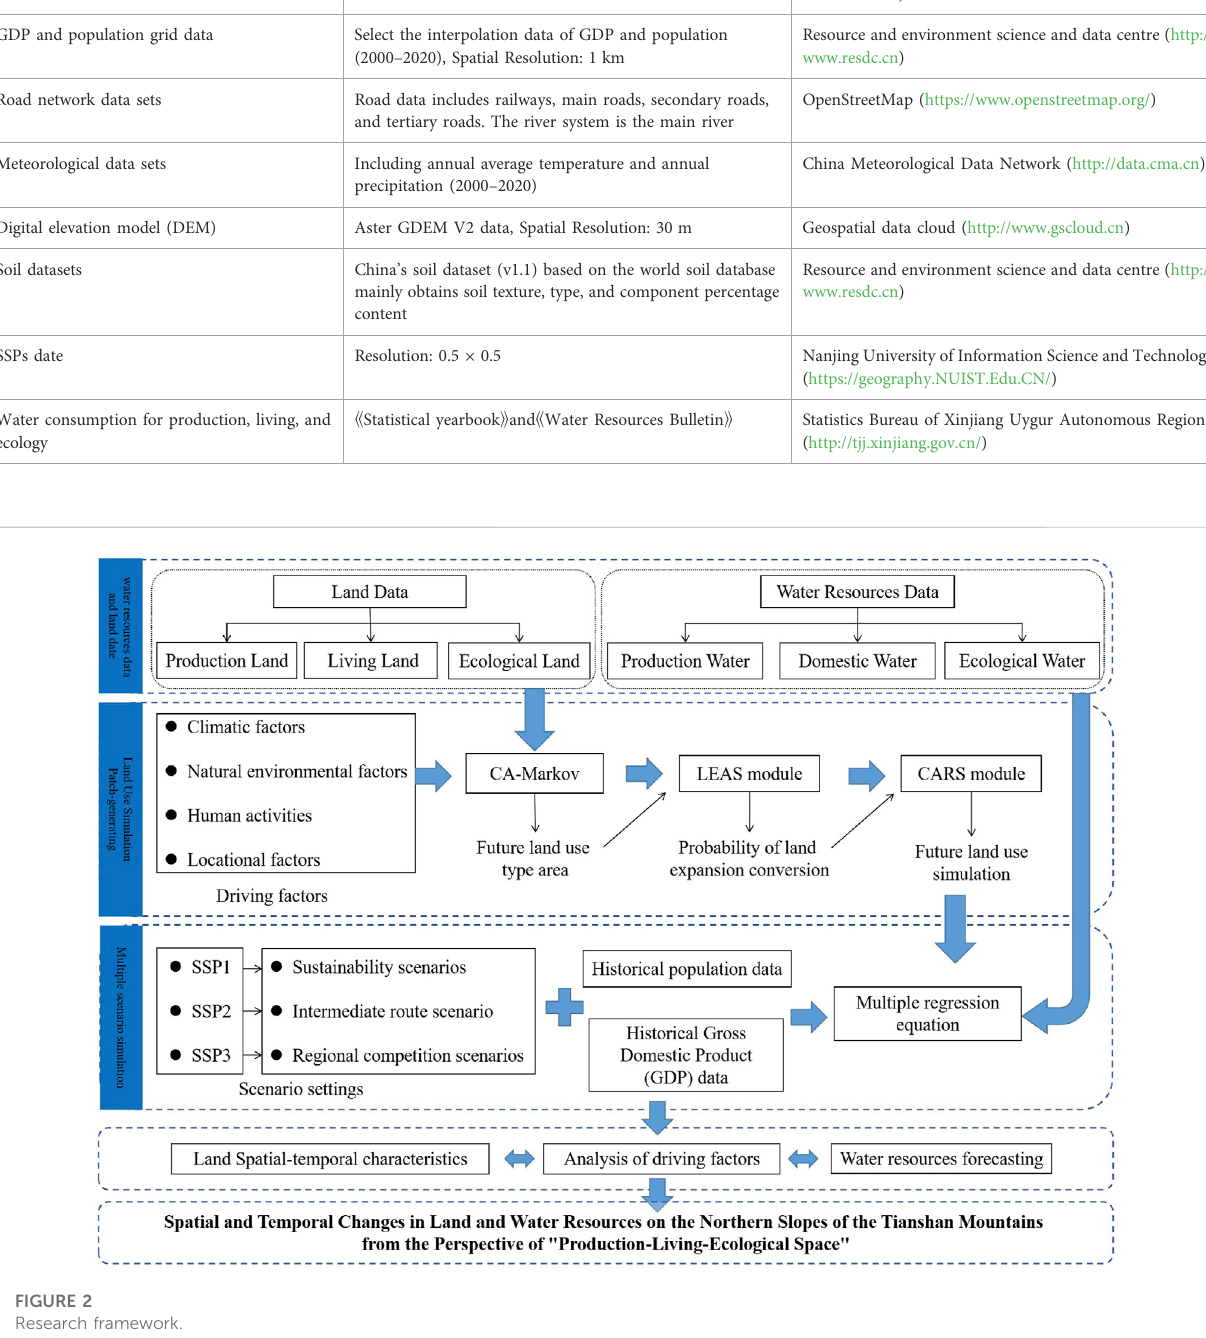
25 secondary classi fi cations (Liu et al., 2017). With research on the ecological environment, many scholars have proposed a classi fi cation scheme for ecological land from an environmental perspective (Wang J. et al., 2017), and a land use classi fi cation scheme based on the perspective of industrial structure and economic development (Liu et al., 2018). This classi fi cation uses